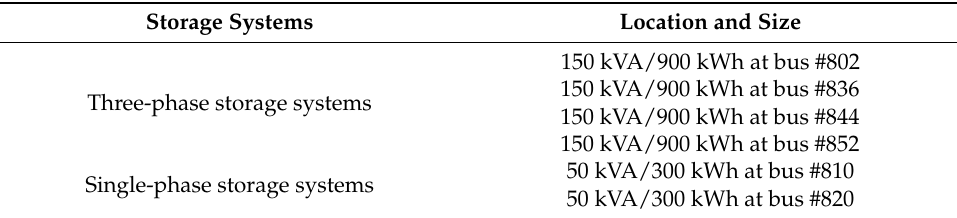
Table 6. Optimal location and size of energy storage systems for mode 1 by applying the μ GA.